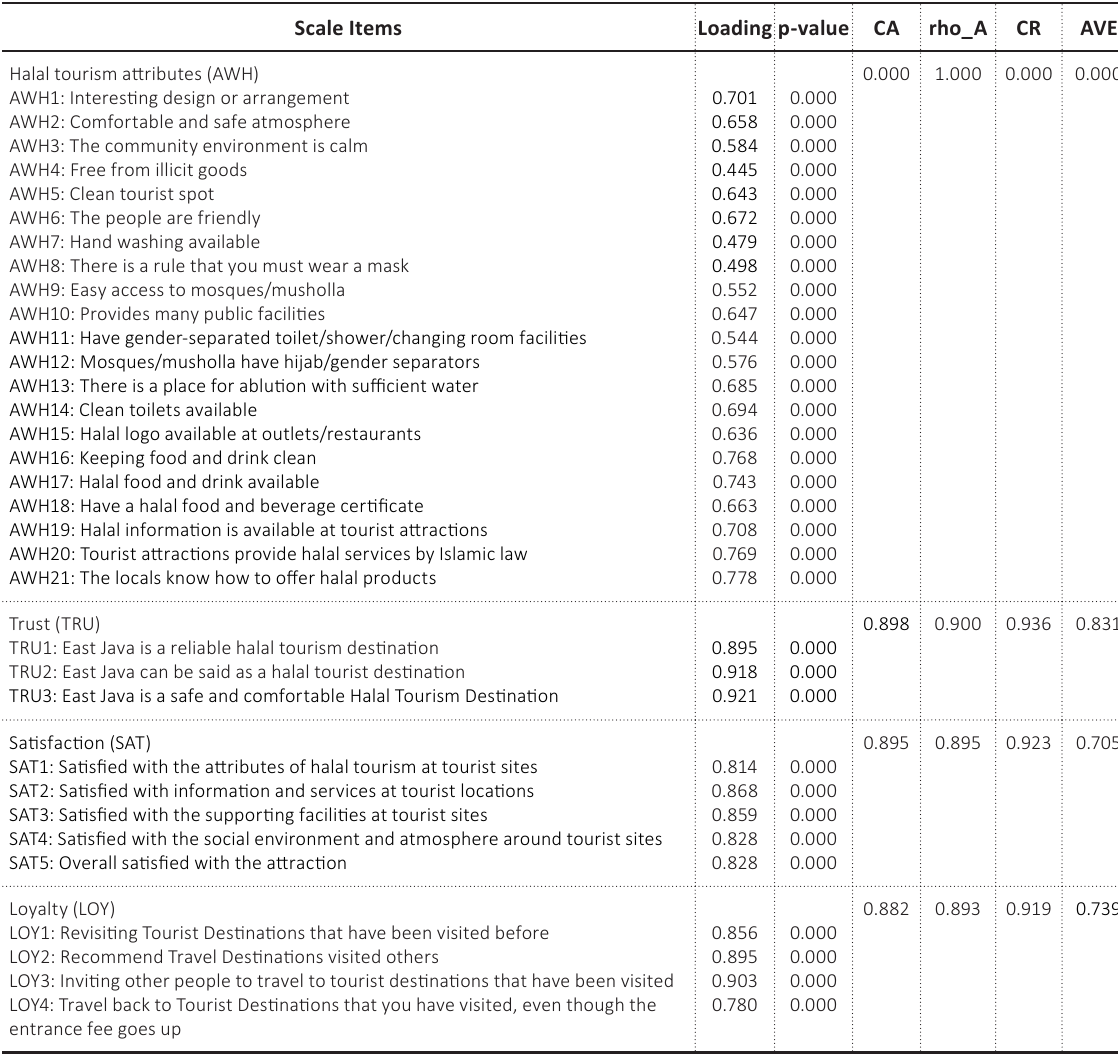
Source: Data processed,